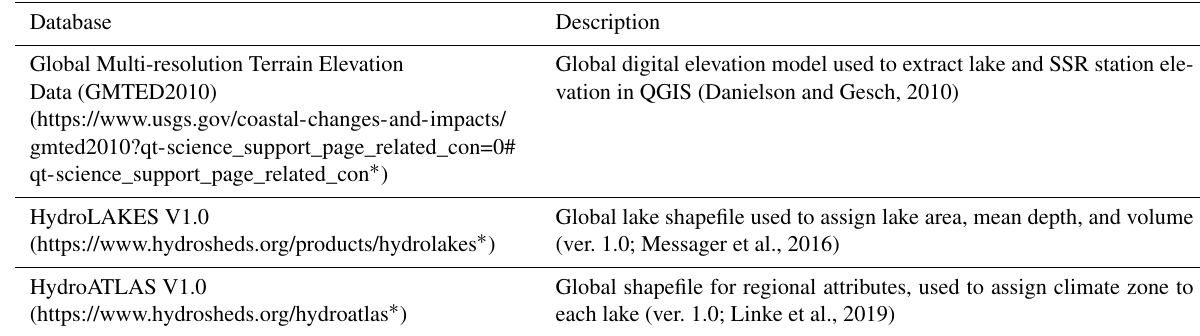
Table A3. Summary of miscellaneous databases used to acquire lake attributes. Follow embedded links to access the database and metadata. ∗ Last access: July